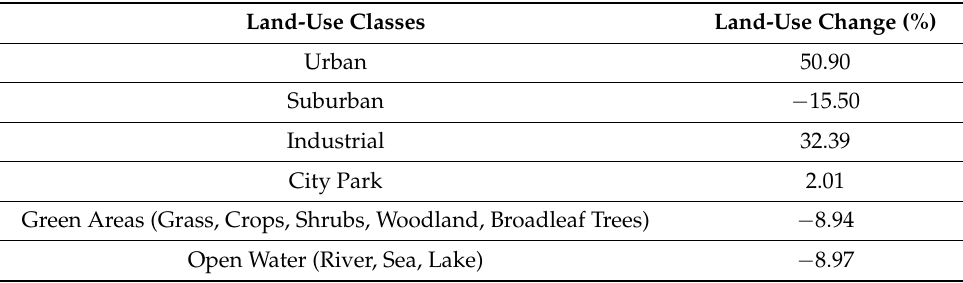
Table 1. Land-use change between 1997 and